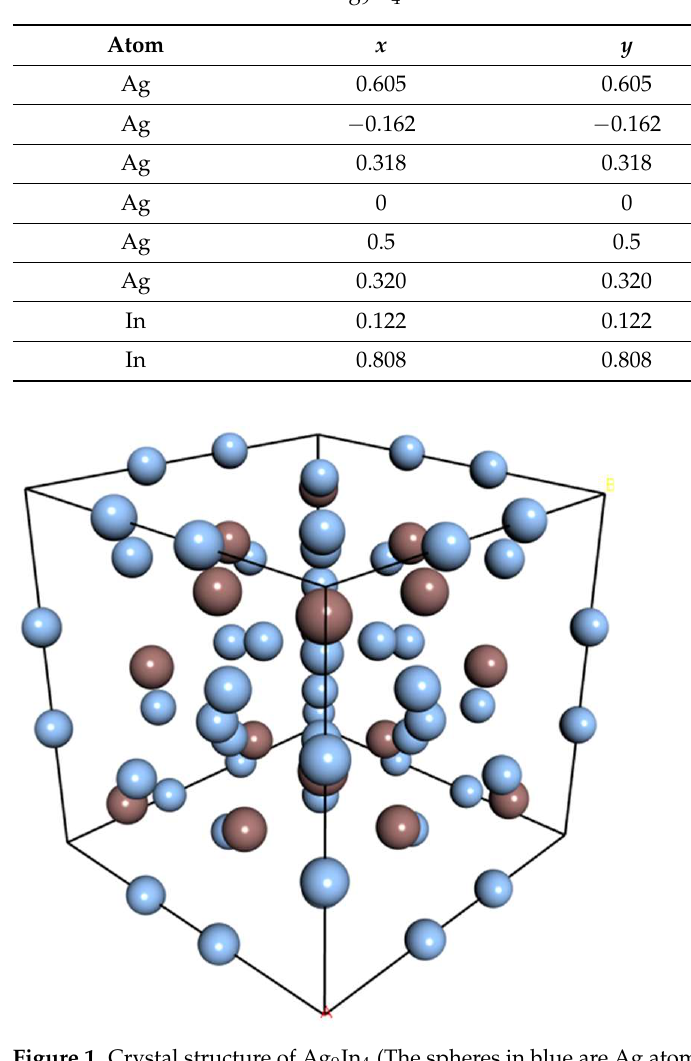
Table 1. Atomic coordinates for Ag 9 In 4 before relaxation.